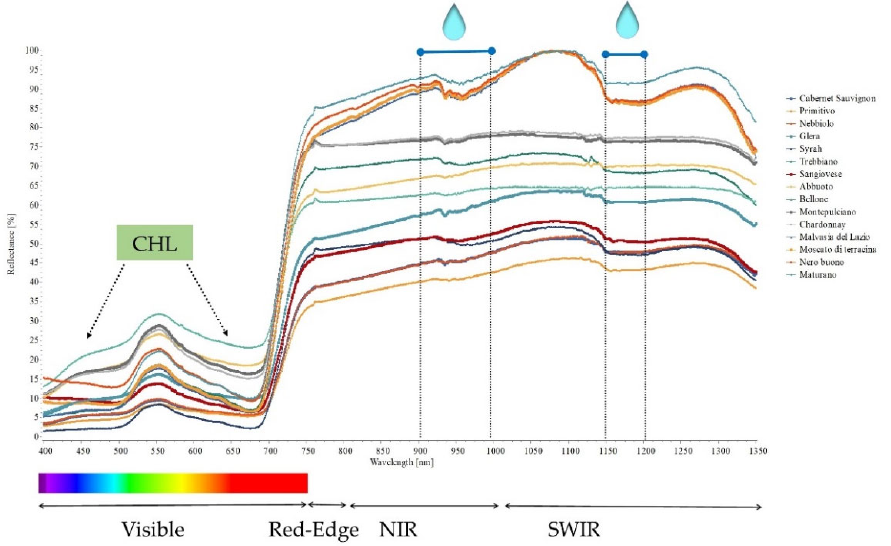
Figure 6. Hyperspectral signature of the tested cultivars. Measurements refer to the highest stress conditions, BBCH 089 (berries ripe for harvest).